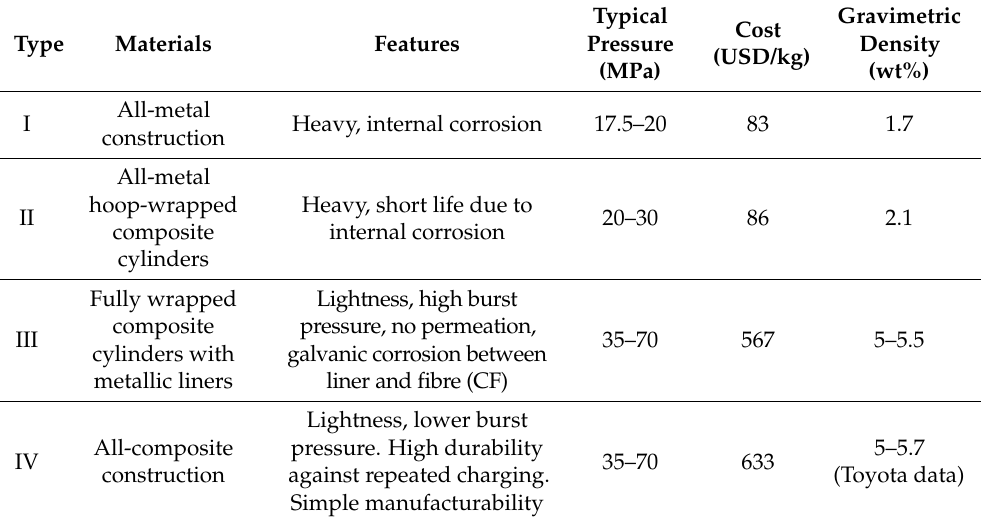
Table 1. Different types of compressed gas hydrogen tanks